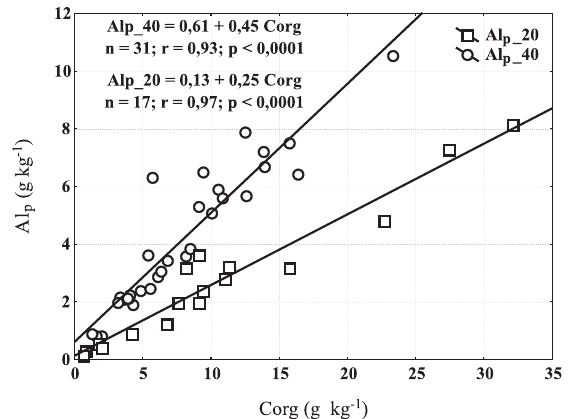
) para o p /Corg) x p